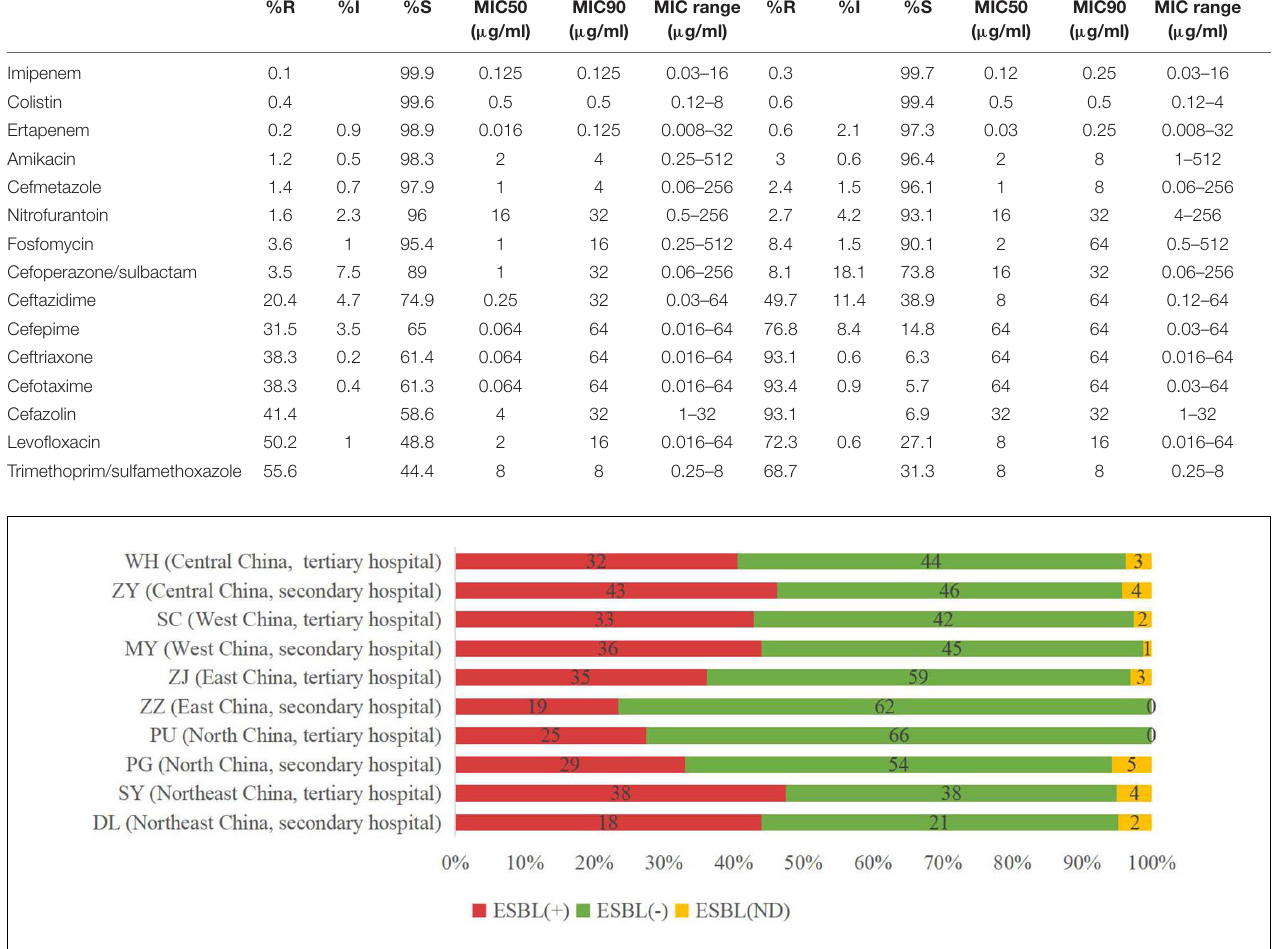
TABLE 2 | The antimicrobial susceptibilities of 809 Escherichia coli strains isolated from community-acquired urinary tract infection (CA-UTI) in China. Antibiotic All isolates ( n = 809) ESBL-producing and ESBL-uncertain isolates ( n = 332)